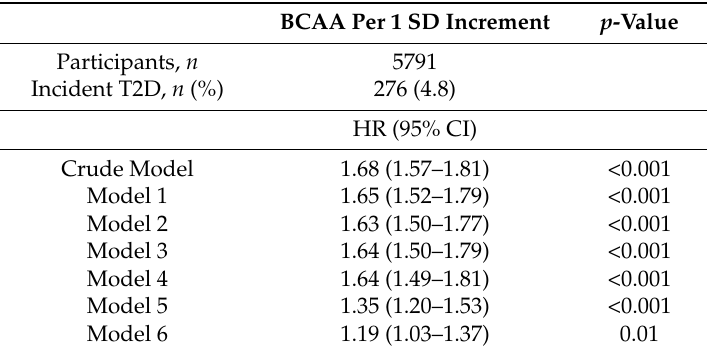
Table 4. Prospective associations of plasma total branched chain amino acids with incident type 2 diabetes.